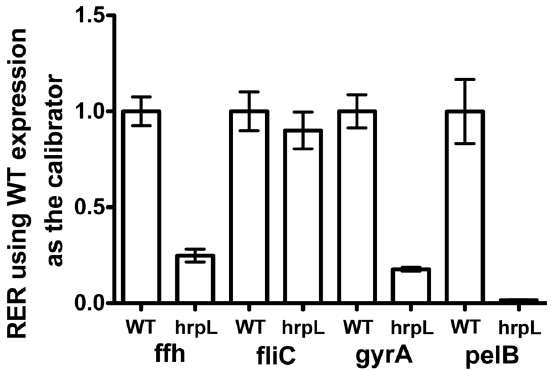
Figure 6. Inplanta expression of select P.carotovorum genes dspE and hrpL at 5 hpi. Relative expression of the ffh , fliC , gyrA and pelB transcripts in A. thaliana Col-0 leaves was determined with two validated reference mRNA ( recA and proC - Table S2). The mean relative expression ratio (RER) of the ffh , fliC , gyrA and pelB transcripts in the hrpL mutant was 0.25, 0.90, 0.18 and 0.015, respectively, compared to expression in the wild type strain. The mean normalized transcript abundance relative to reference mRNA was used as the calibrator. The difference in the RER means in the hrpL mutant compared to wild-type for all target transcripts except fliC was found to be significant at a 95% confidence interval by Anova with a Tukey Post Test using Prism software (Mac version 5.0c, GraphPad Software, Inc.). Error bars represent standard error of the mean.